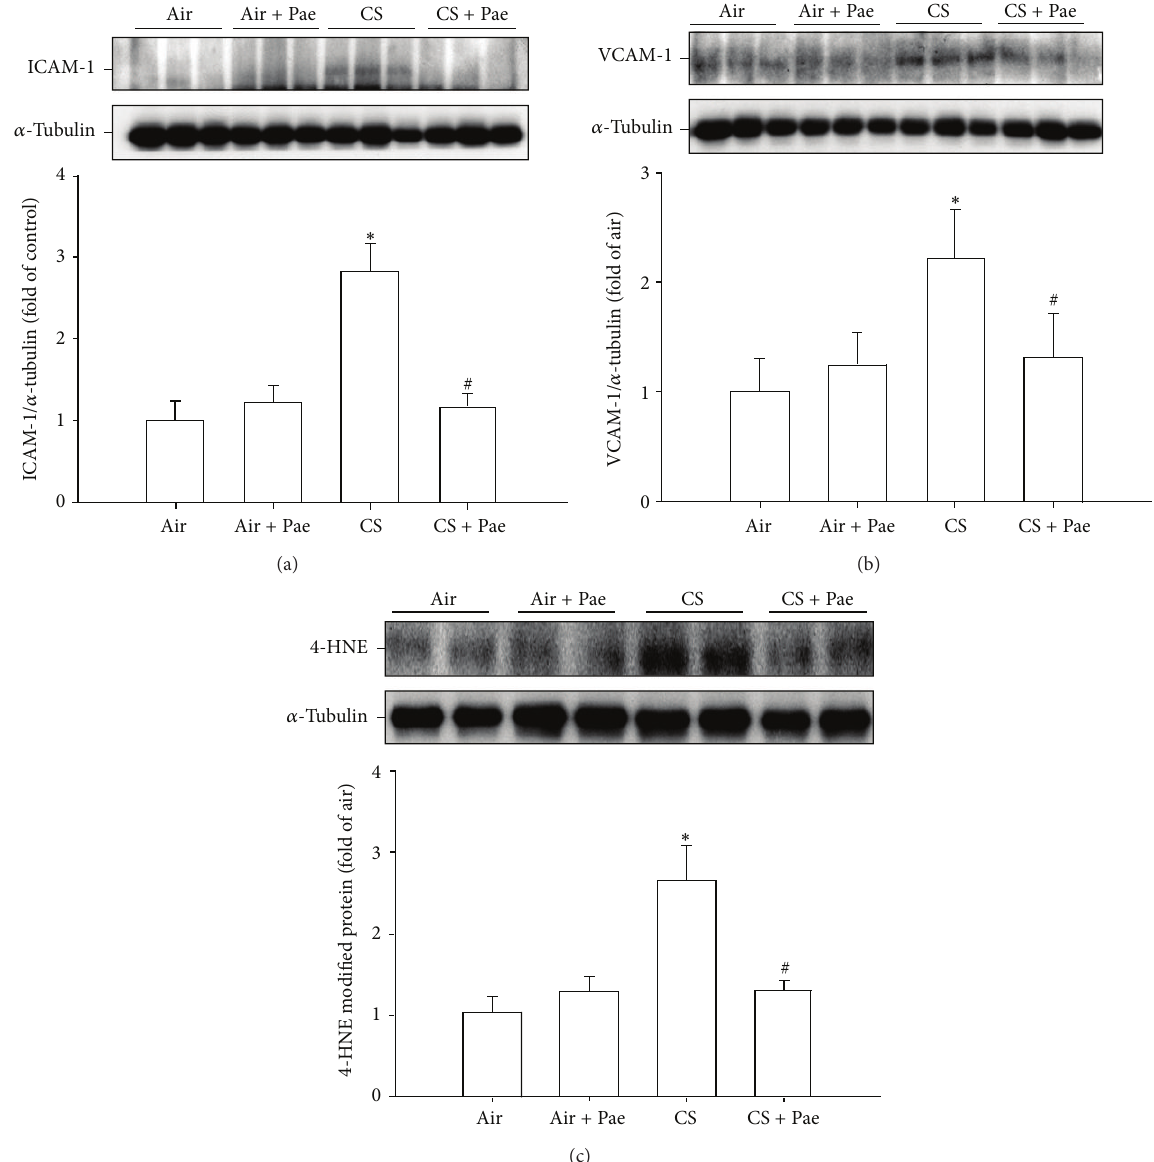
Figure 4: Paeonol (Pae) suppresses cigarette smoke- (CS-) induced increases in expression of inflammatory target proteins ((a), (b)) and oxidative stress-related proteins (c) in lung tissues samples from mice. (a) Intercellular adhesion molecule 1 (ICAM-1); (b) vascular cell adhesion molecule 1 (VCAM-1); (c) 4-hydroxynonenal (4-HNE) modified proteins (a biomarker of oxidative stress). Protein levels in the lung tissues were analyzed by Western blotting. Data in each group are mean ± SEM from 7 mice. ∗ 𝑃 < 0.05 versus the air-exposure group; # 𝑃 < 0.05 versus the CS-exposure group with vehicle treatment. See legend of Figure 1 for detailed information on each study group.